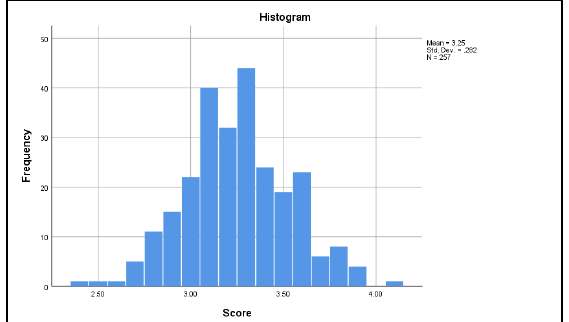
Figure 7. Histogram of Test